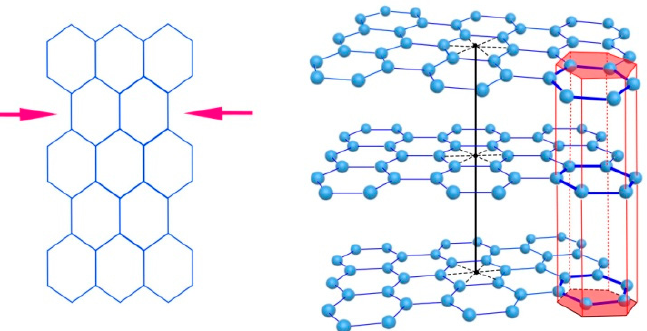
Figure 4. Deformation of a graphene layer ( left ) and displacement of flat graphene layers relative to each other in the stack ( right ).